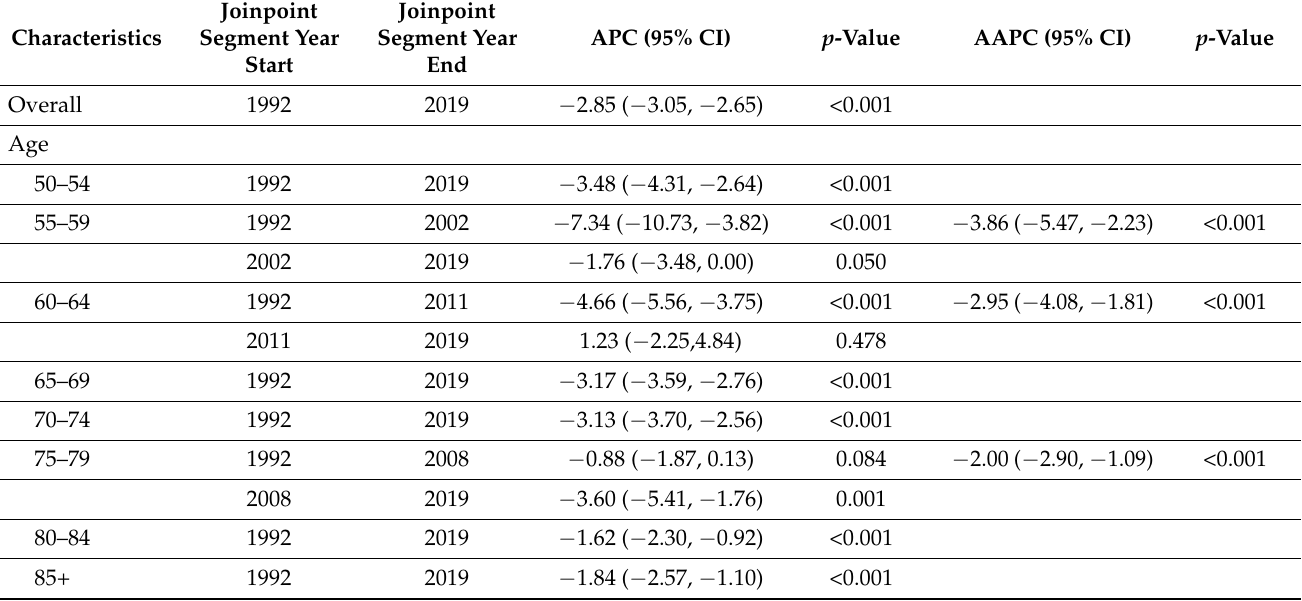
Table 3. Annual percent change (APC) and average annual percent change (AAPC) in ESCC rates over time, overall, and by age group, sex, and